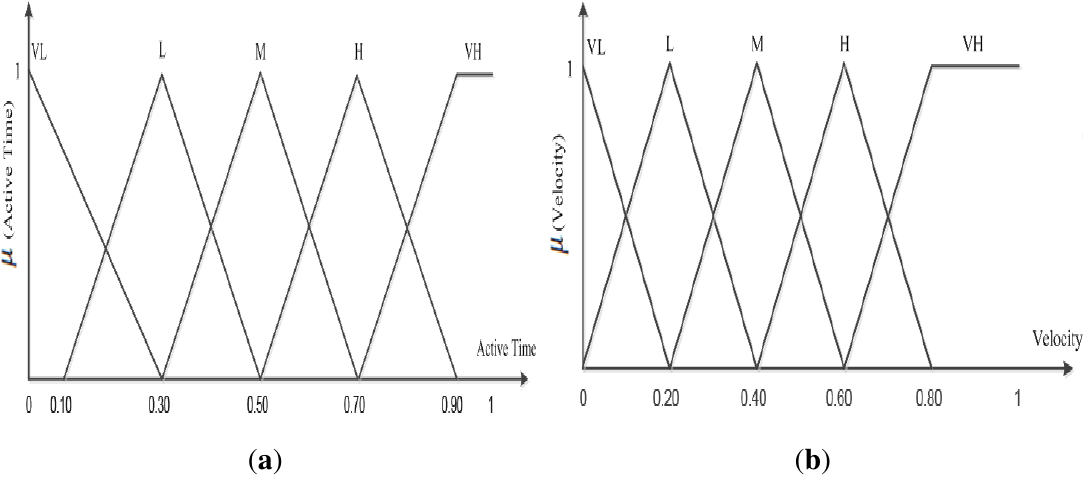
Figure 4. Fuzzy membership function. ( a ) Fuzzy membership function for A membership function for